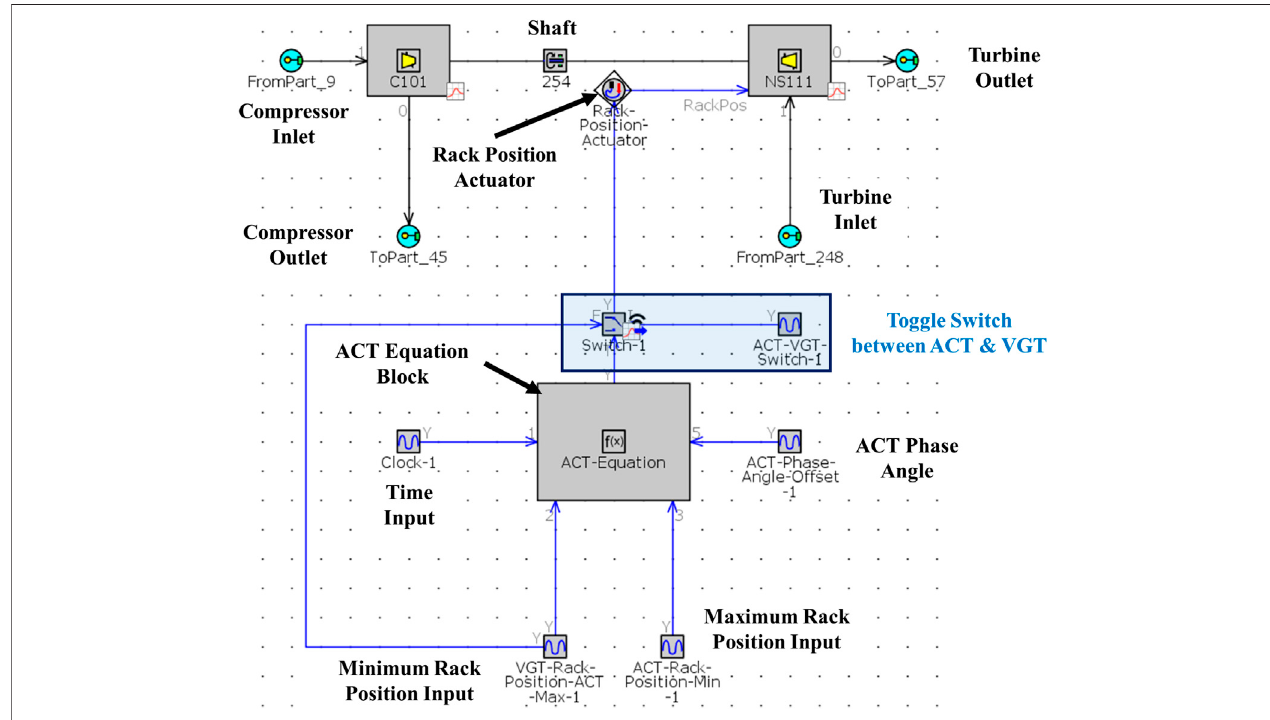
FIGURE 5 | ACT control circuit in the GT-POWER model. Note that the VGT rack controller template has been removed and replaced with an ACT equation block templatewhichrequiresthesimulationclock,minimumrackposition,maximumrackposition,andphaseangleasinputs.Atoggleswitchisalsoincludedinthiscircuitto switch between VGT and ACT if needed. Structure of this circuit is similar to the Ricardo WAVE setup found in Pesiridis et al. (2011).